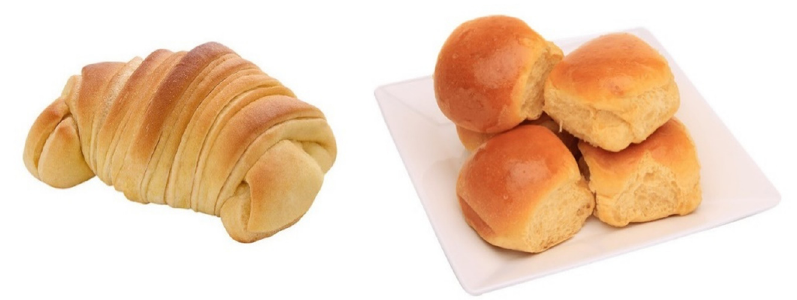
Figure 8: Brioche croissant ( left ) and brioche bread ( right ) .